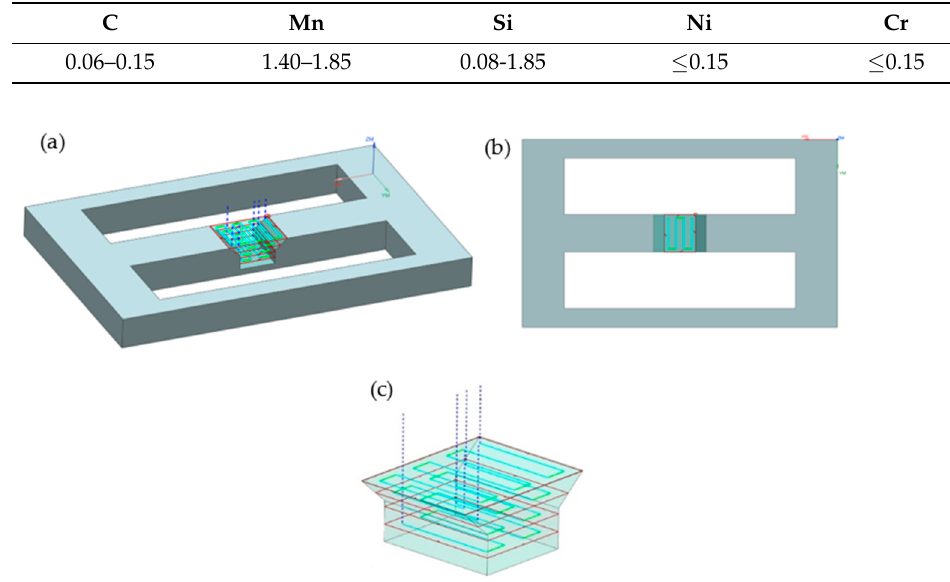
Figure 2. Sketch of weld path. ( a ) Whole welding path from isometric view; ( b ) Welding path at first layer from the top view; ( c ) Whole welding path without